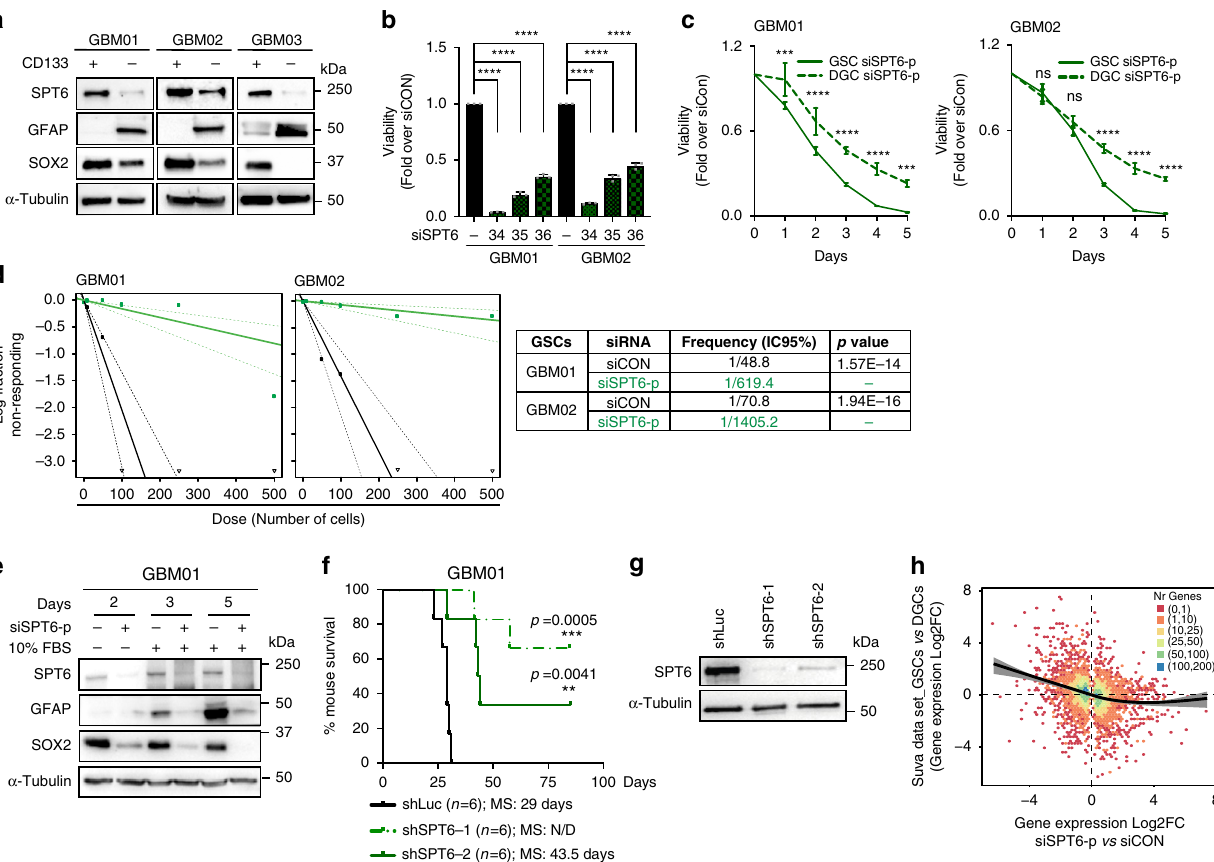
Fig. 2 SPT6 as a regulator of genomic stability in GSCs. a Representative immunoblot analysis of SPT6, GFAP and SOX2 expression in GSCs and DGCs in GBM01, GBM02 and GBM03 lines. b Viability assay of GSCs (GBM01, GBM02) transfected with siCON or siRNAs targeting siSPT6 (siSPT6-34; siSPT6- 35; siSPT6-36. Data are presented as mean values± s.d. **** p < 0.0001; two-way ANOVA analysis with Sidak ’ s multiple comparisons test. c Viability assay of matched GSCs and DGCs (GBM01; GBM02) transfected with siCON or siSPT6-p. Data are presented as mean values ± s.d and normalized to siCON. GBM01: *** p = 0.005 (1 day), **** p < 0.0001 (day 2, 3, 4), *** p = 0.0001 (day 5); GBM02: non-signi fi cant p = 0.866 and p = 0.192 (day 1, 2, respectively), **** p < 0.0001 (3, 4, 5 days); two-way ANOVA and Sidak ’ s multiple comparisons test. ( d ) Representative extreme limiting dilution assay (ELDA) of GSCs (GBM01 and GBM02) transfected with siCON or siSPT6-p. Respective p -values (GBM01 p = 1.57E-14; GBM02 p = 1.94E-16 by ELDA analysis program) are listed in a table summary. e Representative immunoblot analysis of SPT6, GFAP, and SOX2 expression in GSCs transfected with siCON or siSPT6-p undergoing serum-(FBS)-induced differentiation. ( f ) Kaplan – Meier survival curves of mice implanted with GBM01 GSCs with silenced SPT6 (shSPT6-1 and shSPT6-2) compared to control (shLuc). n = 6 mice in each arm. ** p = 0.0041; *** p = 0.0005; Log-rank/Mantel-Cox test. MS median survival, ND non- determined. g Representative immunoblot validation of SPT6 knockdown ef fi ciency in GSCs used in ( f ). h Spearman correlation analysis of SPT6 expression and stem cell transcriptional signature using the Suva data set 28 . r s : − 0.281, p -value < 2.2e-16. X -axis: positive values upregulated after SPT6 loss. Y -axis: positive values upregulated in GSCs cells. Color indicates the number of genes in each region. The black trend line is calculated as a smoothed average along the X -axis where the shaded region indicates standard error. N = 3 biologically independent experiments in ( a – e ), ( g ). Loading control: α - Tubulin in ( a ), ( e ), ( g ). Source data are provided as a Source data fi